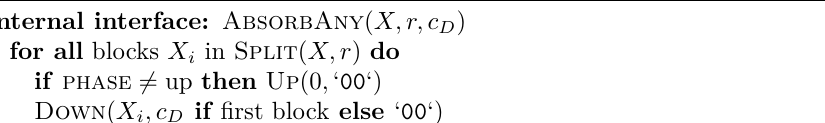
Algorithm 2 Internal interfaces of Cyclist [ f, R hash , R kin , R kout , ‘ ratchet